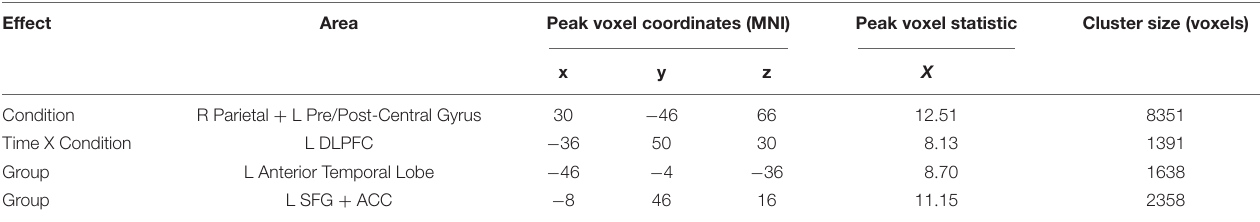
FIGURE 3 | Measure of distraction, defined as the difference in d’ between the AV and one deviant condition. A positive value indicates the costs on Sensitivity induced by the presence of a deviant stimulus. A negative value indicates a facilitation effect induced by the deviant stimulus. (A) The auditory strand containing the AV and AV+AudDev conditions. At both timepoints, the auditory deviant distracted participants of both groups. (B) The visual strand, containing the AV and AV+VisDev conditions. The visual deviant stimulus was non-distractive pre-training and facilitating post-training, for both groups. AV, score for the main audiovisual task without distractors; AV+AudDev, score for the main audiovisual task in the presence of the auditory distractor; AV+VisDev, score for the main audiovisual task in the presence of the visual distractor ∗∗ p < 0.01; ∗∗∗ p ≤ 0.001; n.s. = non-significant comparison. Error bars show 95% CI. TABLE 2 | Summary of results from the statistical analysis of the source